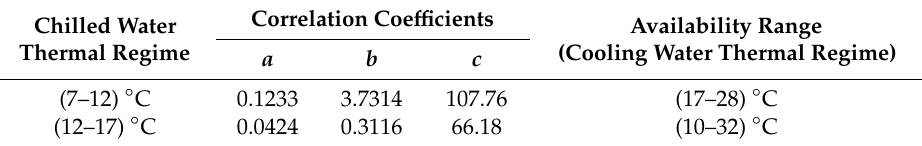
Table 5. The coe ffi cients of the hot water temperature correlation. Table 5. The coefficients of the hot water temperature correlation.